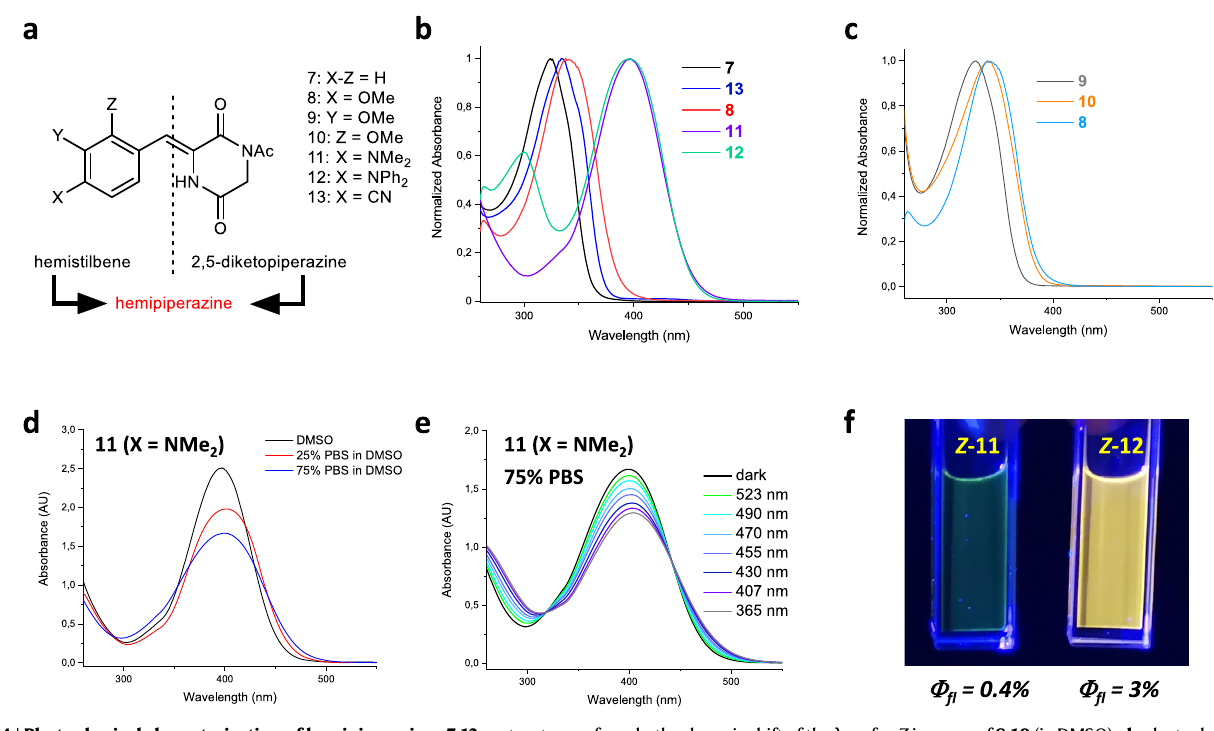
bathochromicshiftofthe λ max for Z- isomersof 8-10 (inDMSO); d solvatochromism of 11 in aqueous solutions; e photochromism of 11 in aqueous solution containing 25% DMSO; f comparison of the fl uorescence intensity between Z- 11 and Z- 12 in